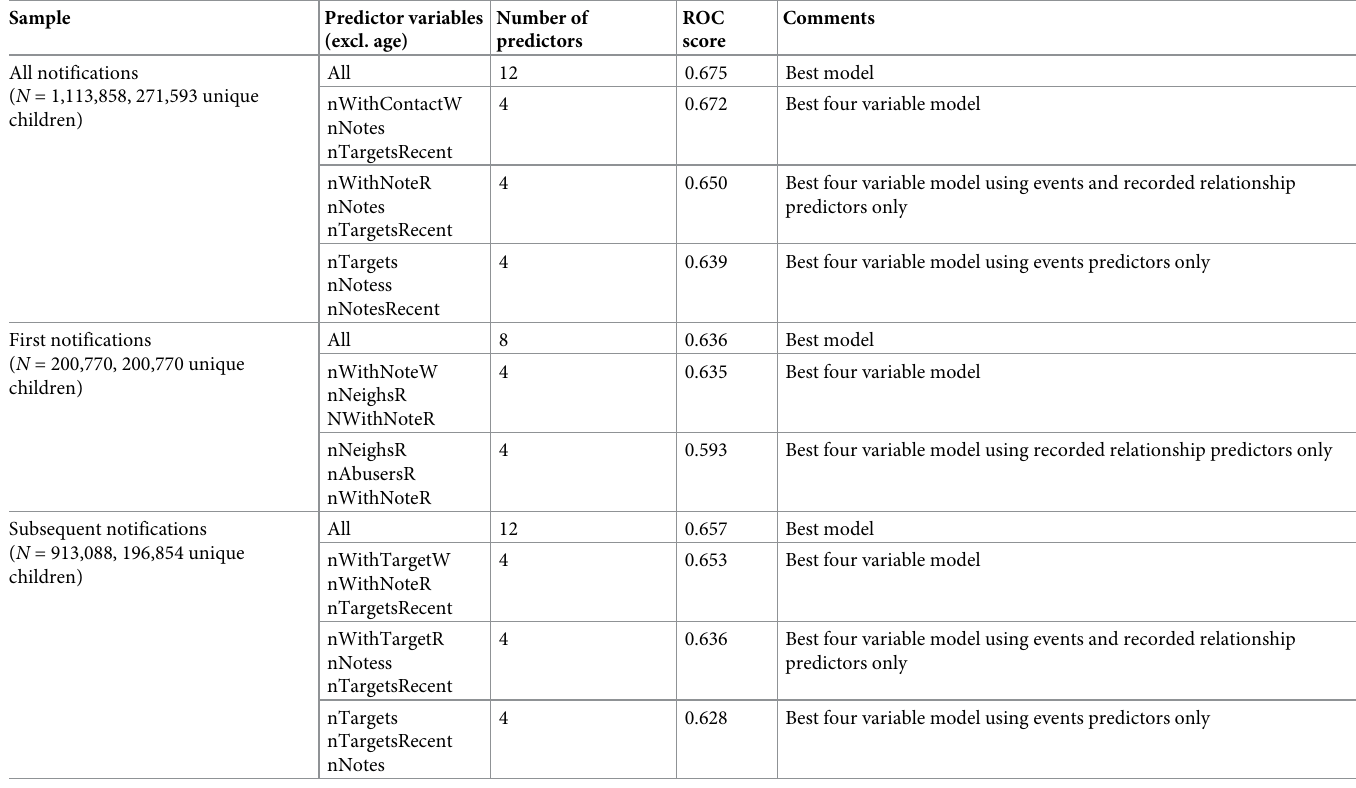
Table 2. Models using whole-life relationships are always better than those without whole-life relationships. Results for selected logistic regression models for esti- mated concern. Columns show the dataset used, the predictor variables included (see Table 1 for definitions), the number of predictor variables and the ROC score. For each dataset, results are shown for the best overall model (i.e. highest ROC score), the best four-variable model, and the best model that does not have any whole-life net- work predictor variables. Note that the model using events-based predictor variables only was not applied to the first notifications subsample as these predictor variables are all equal to zero (see